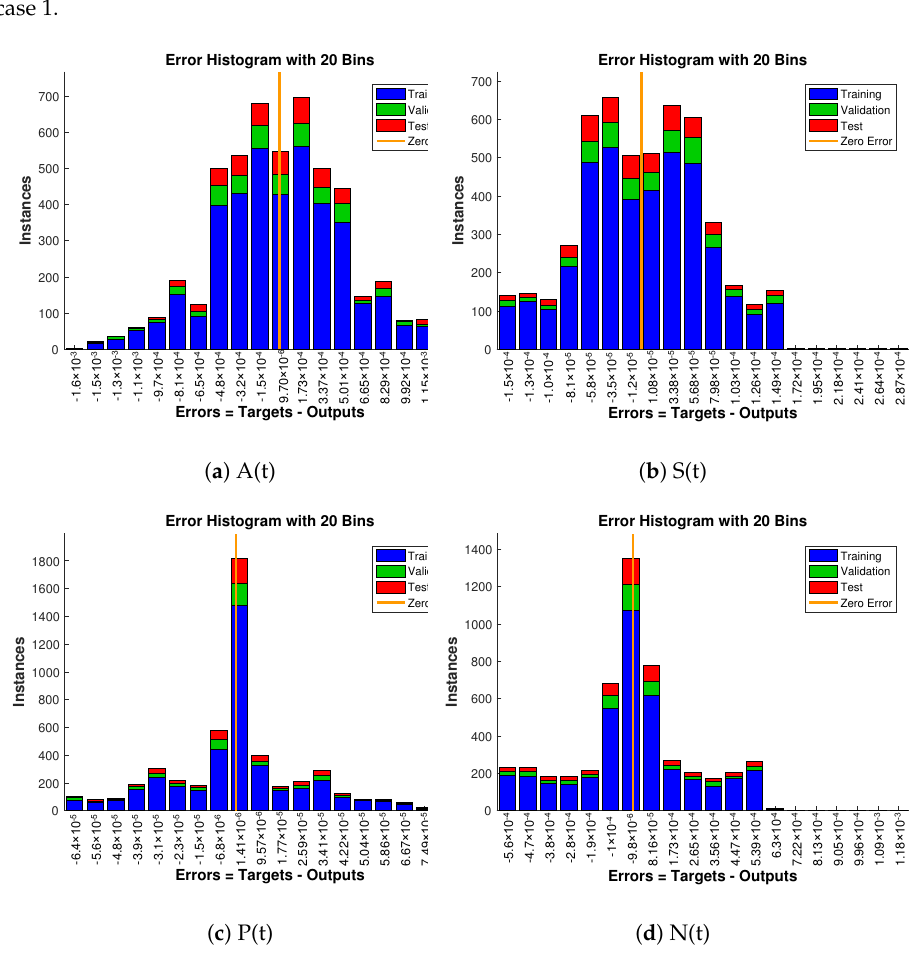
Figure 14. Error histogram analysis in relation to the target data and the approximate solutions for case